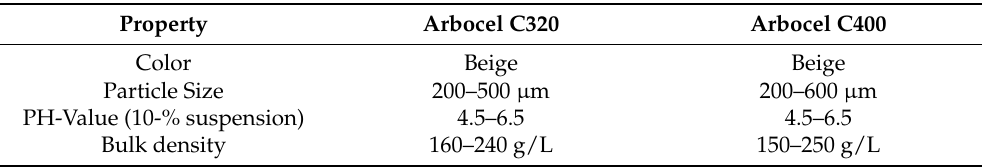
Table 2. Properties of fiber material